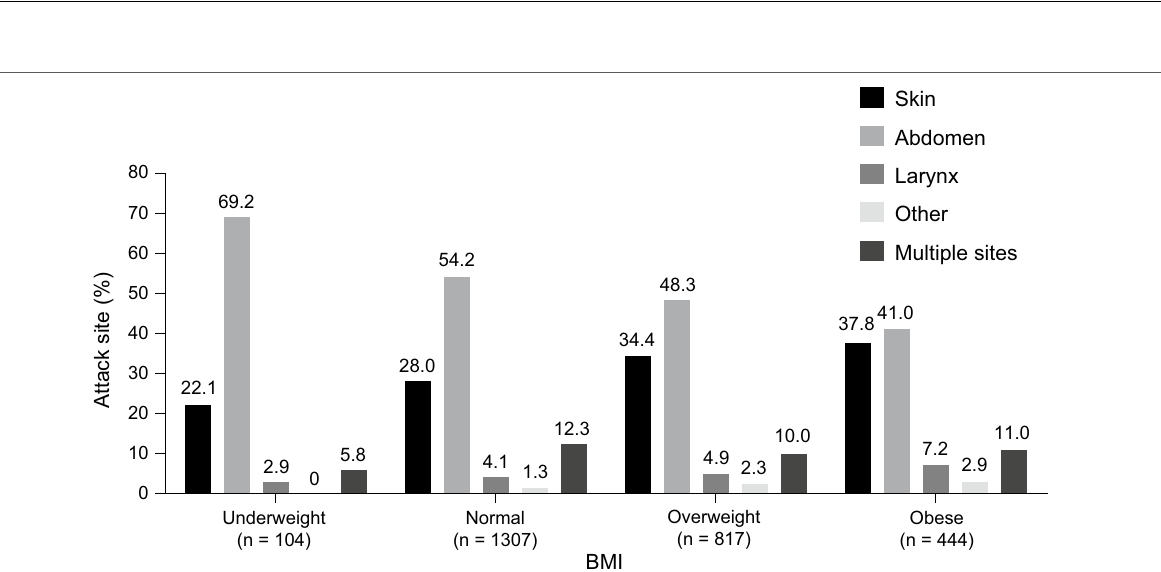
attacks across BMI groups, no statistical difference in the mean duration of attack among the three BMI groups was found (P 0.408 at baseline, P 0.530 at follow-up), = =